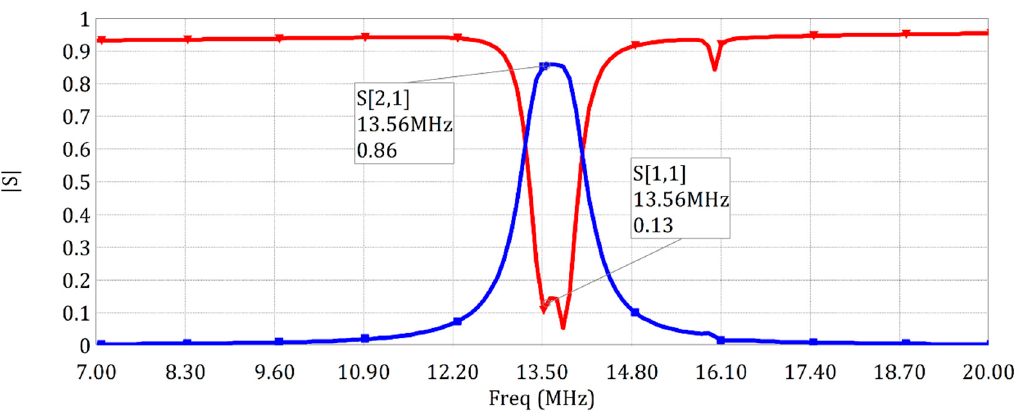
Figure 22. The gain of the hardware implementation of the shielded-CPT system.